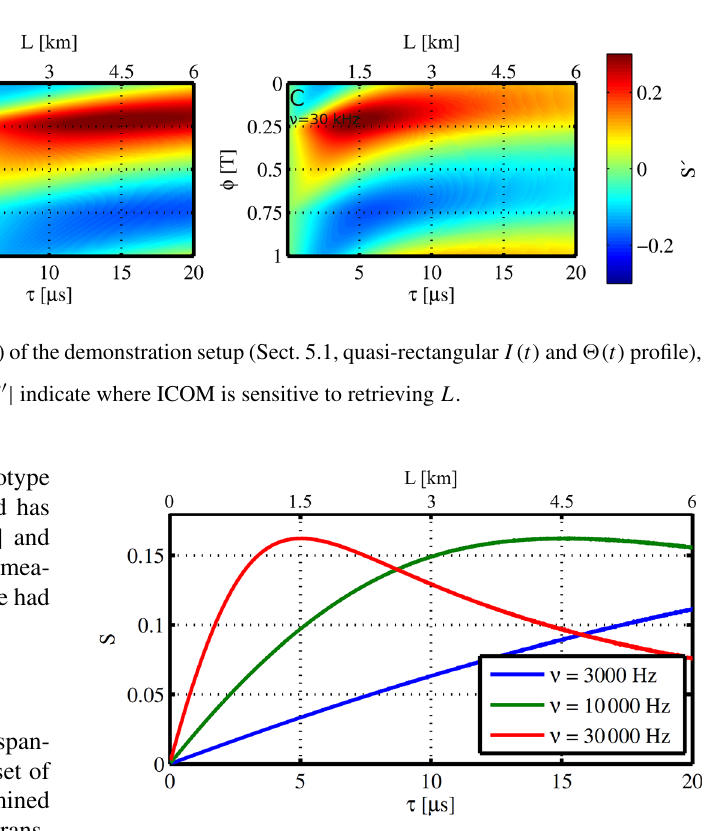
(φ) , as defined in Eq. (4), of the demonstration setup (Sect. 5.1, quasi-rectangular I(t) and (cid:50)(t) profile), Figure 7. Apparent transmission η τ i for three different modulation frequencies ν . Both the variable shape and the position of the extrema can be exploited for the retrieval of L(λ) . Sufficient modulation frequencies ν are necessary for reasonable sensitivity.